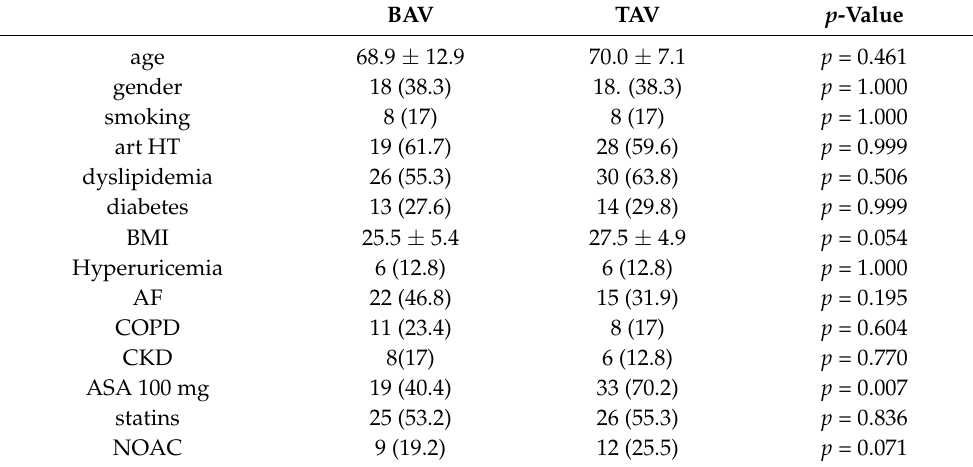
Table 1. Study population.